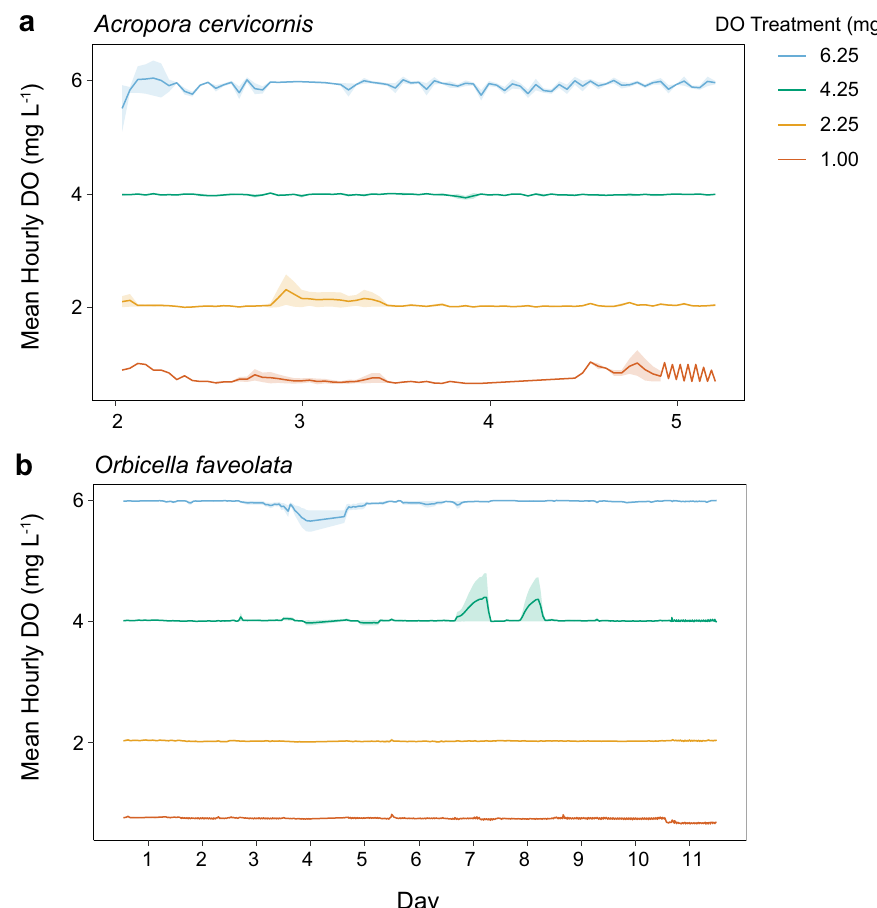
Figure 1. Dissolved oxygen treatment conditions. Mean hourly dissolved oxygen (DO) concentrations in treatment tanks (n = 3), with SD shown as shaded areas around the mean. Oxygen treatments were maintained through an oxygen-feedback, with continuous monitoring every 15 s for the duration of each experiment. ( a ) Acropora cervicornis was exposed to treatment conditions for 5 days and ( b ) Orbicella faveolata for 11 days. Day 1 represents the start of the experiment and first day of biological measurements.